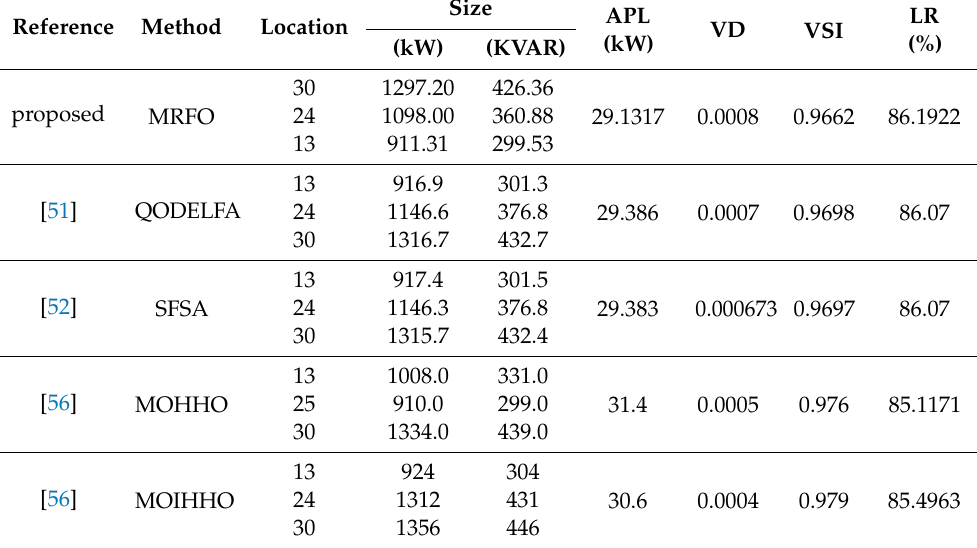
Table 2. 33-bus, three DG units at 0.95 lag pf.